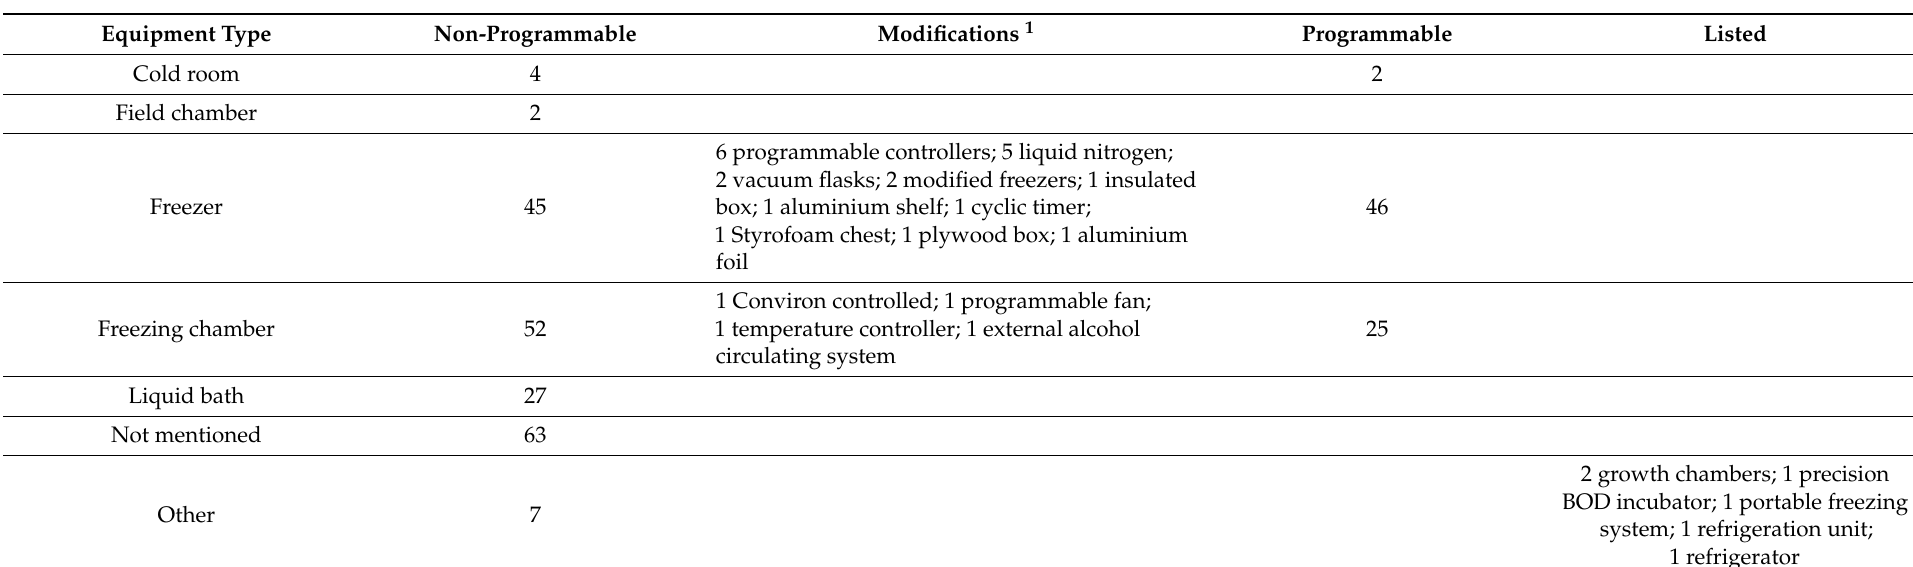
Table 4. Studies according to the freezing equipment